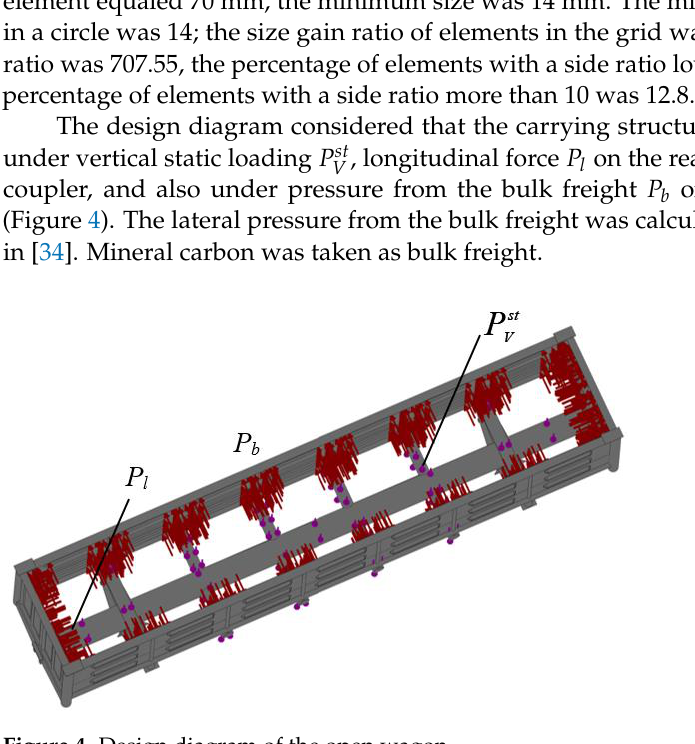
Figure 4. Design diagram of the open wagon.